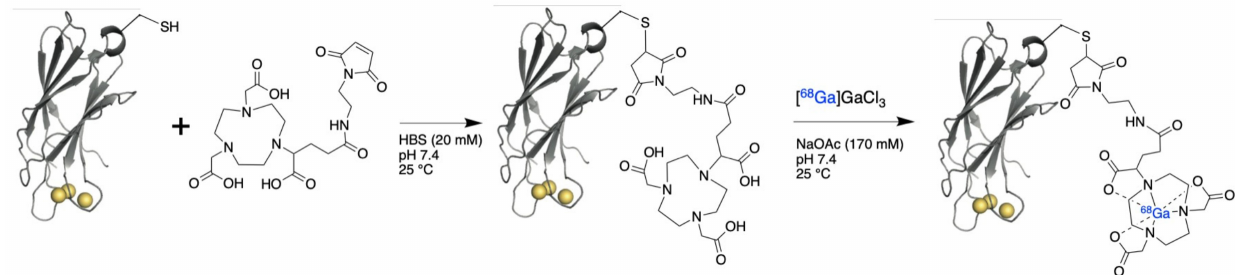
Figure 1. Radiochemical labeling of C2Am, using [ 68 Ga]NODAGA-maleimide, to yield 68 Ga-C2Am. The rapid Michael addition reaction was performed under mild conditions in HEPES-buffered saline (20 mM HEPES, 150 mM NaCl, pH 7.4) at 25 ◦ C. The C2Am active site containing three calcium ions (yellow spheres) and the single cysteine residue (-SH) are